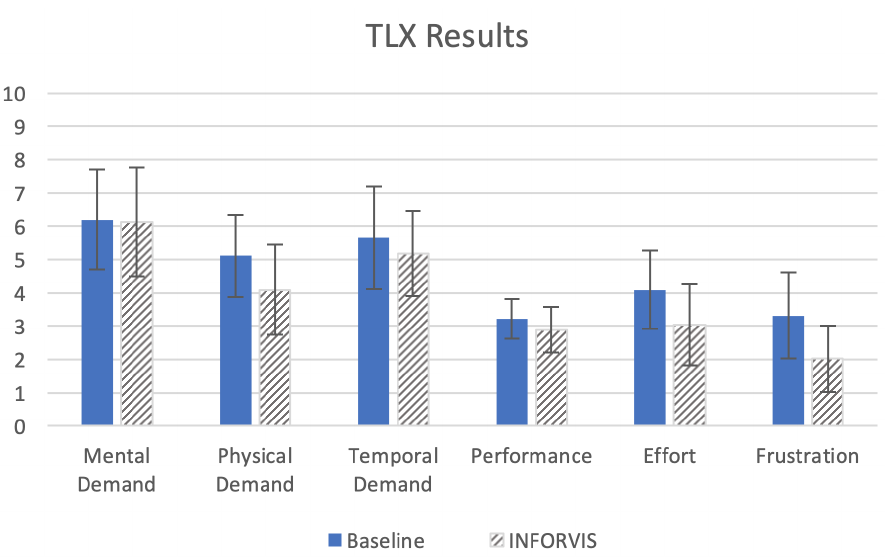
Figure 15. Task load index (TLX) results diagram for 6, self-assessed categories. Each category index is represented by a pair of bars: one for baseline condition (blue-color-filled, left-hand side bars) and another one for INFORVIS system condition (white-grey-hatched, right-hand side